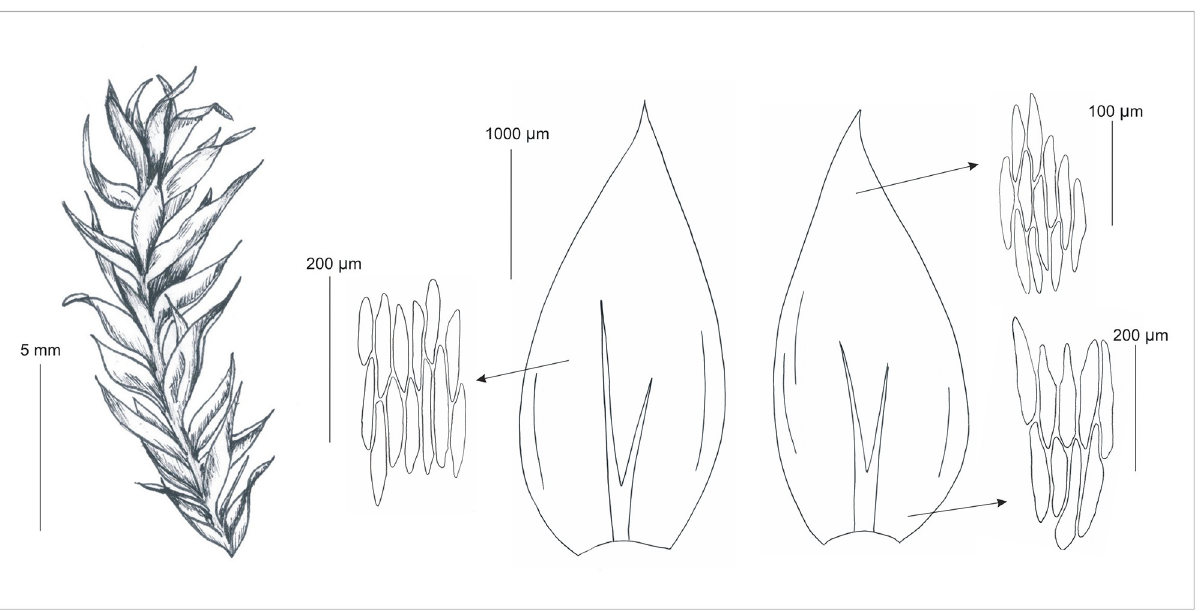
Fig 6. Gametophyte, stem leaves and cells from individual leaf zones of the P . angusticellum . Drawn from the holotype (LOD 14927) G. J. Wolski & A.